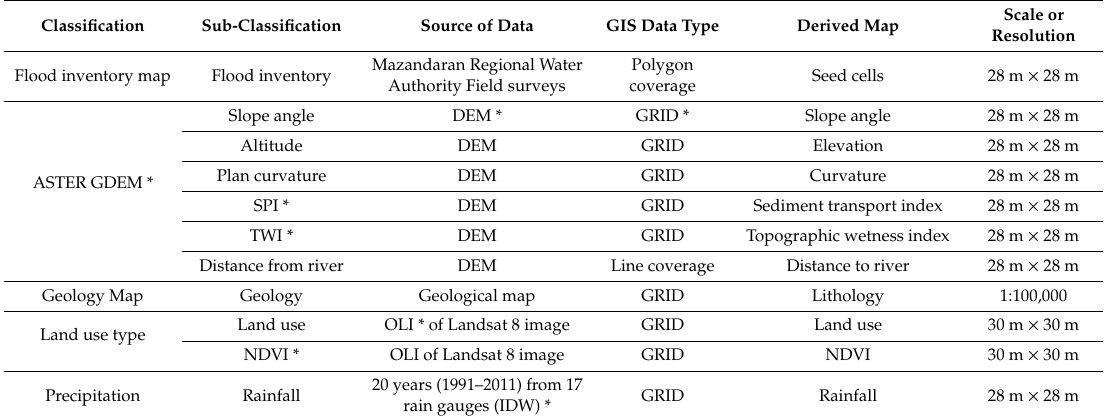
Table 1. Factors used in spatial modeling for flood susceptibility assessment in the study